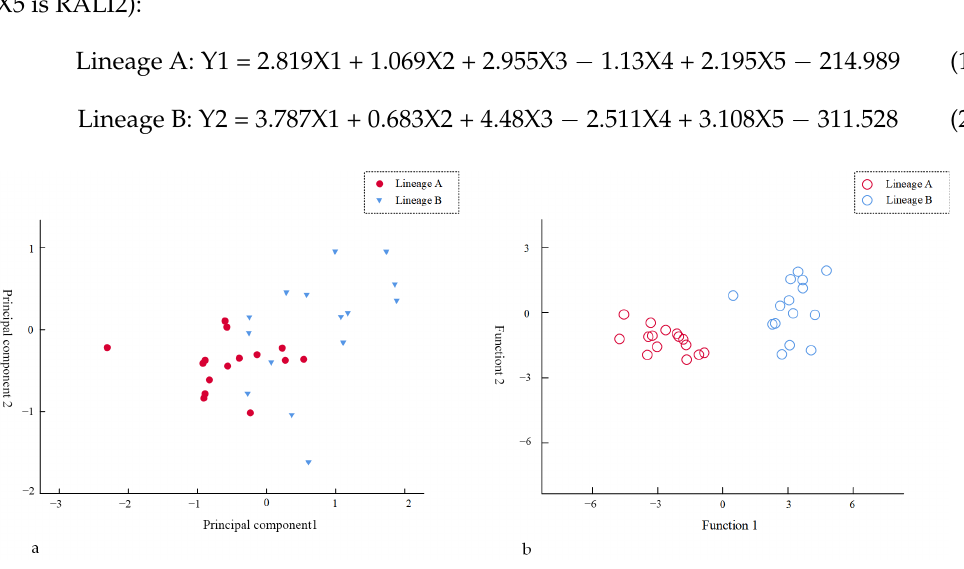
Figure 4. The scatter plot of ( a ) principal component analysis and ( b ) discriminant analysis.